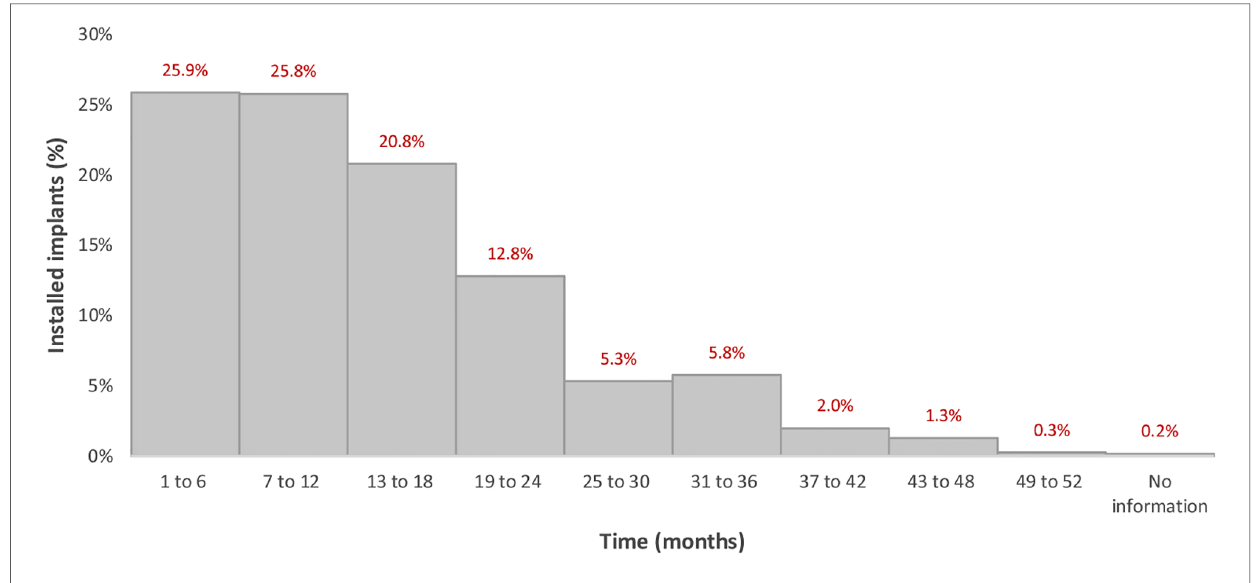
FIGURE 1 Histogram of the installation time of the evaluated